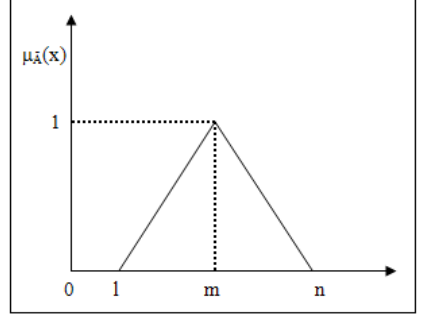
Fig. 1. A triangular fuzzy membership